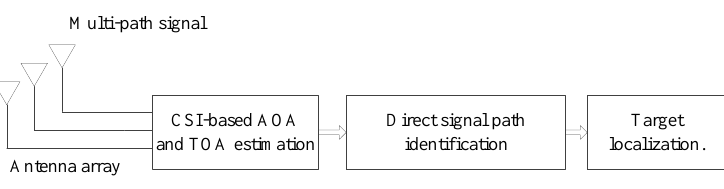
Figure 2. System description.